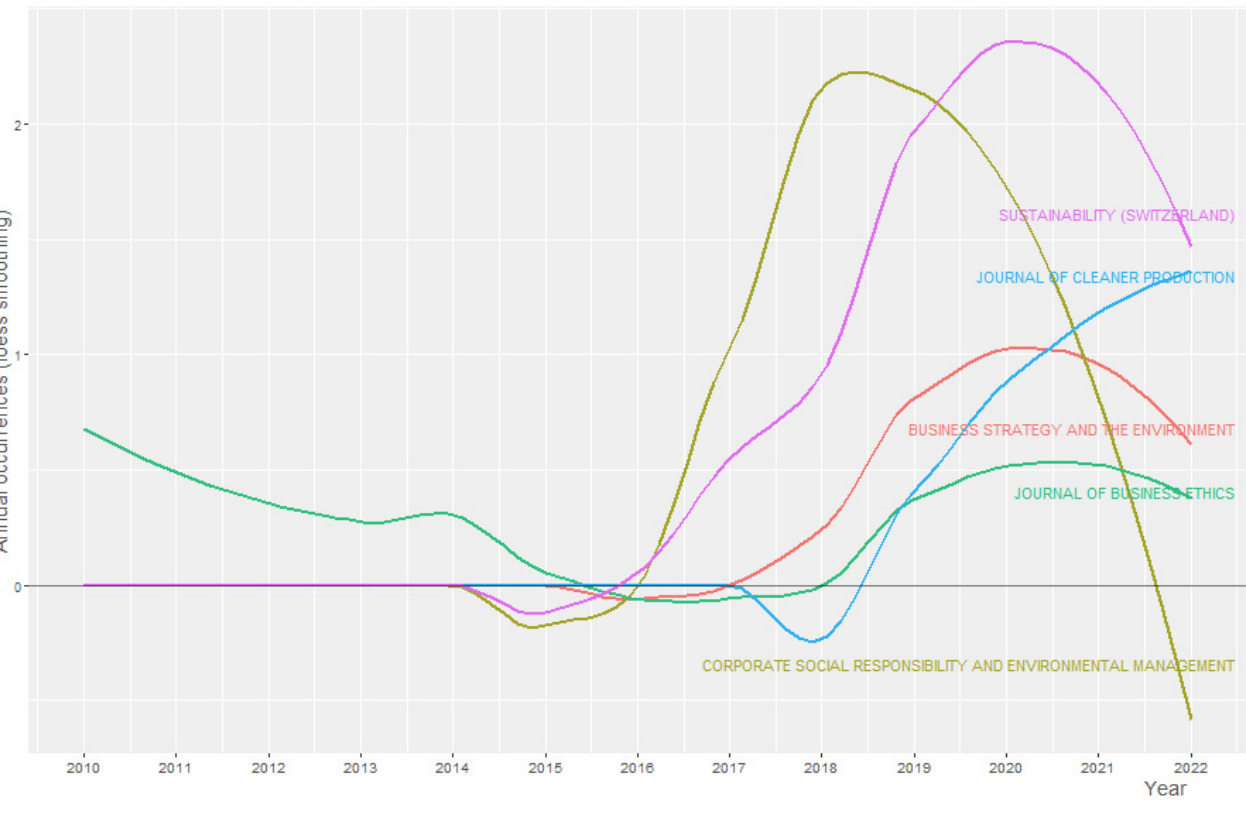
Figure 4. Source Growth.